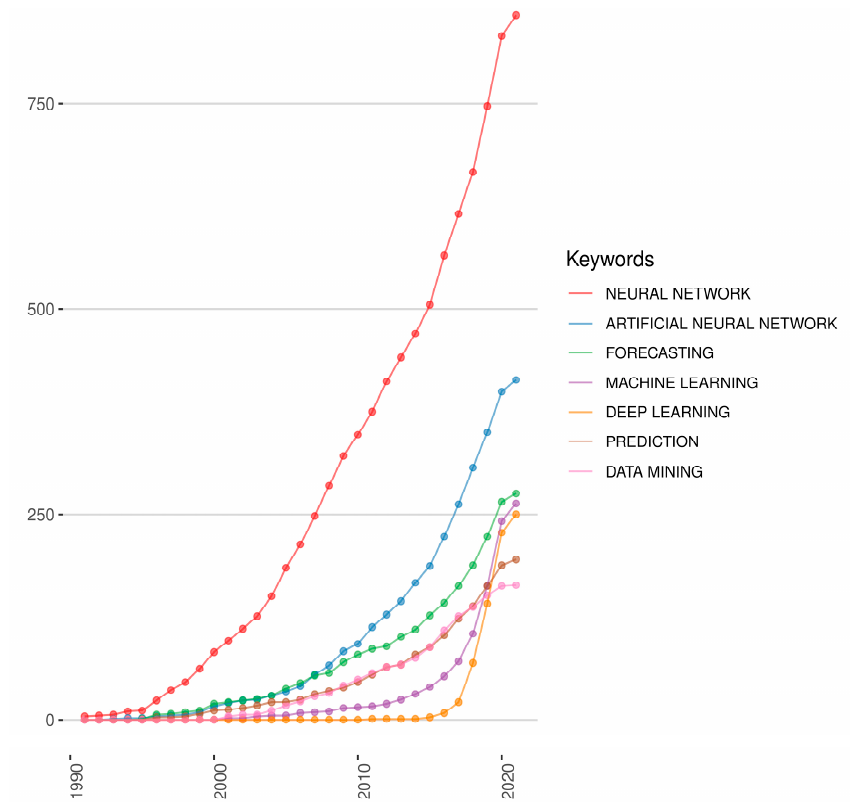
Figure 2. Keywords count through time.